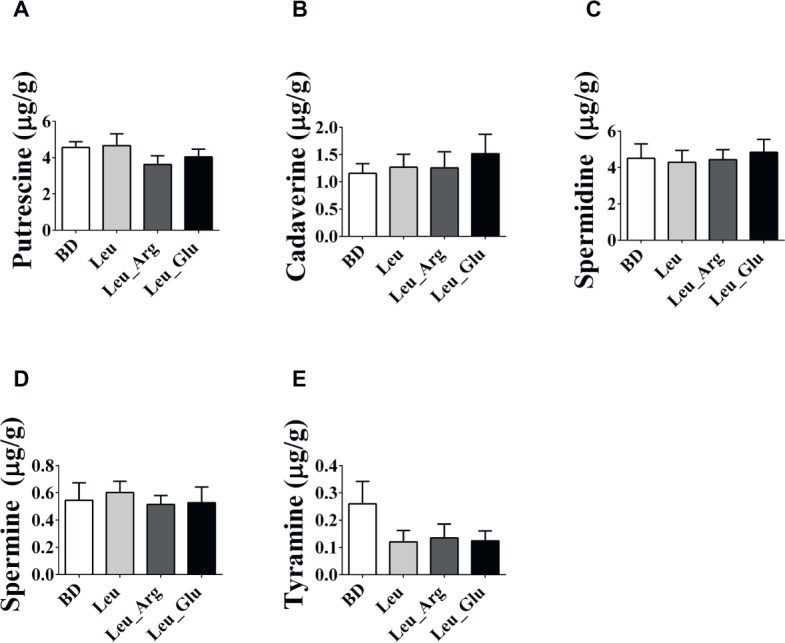
The bioamines concentrations in the colonic contents in finishing pigs. (A-E) Colonic putrescine, cadaverine, spermidine, spermine, and tyramine concentrations, respectively. Data represent the means ± SEM.